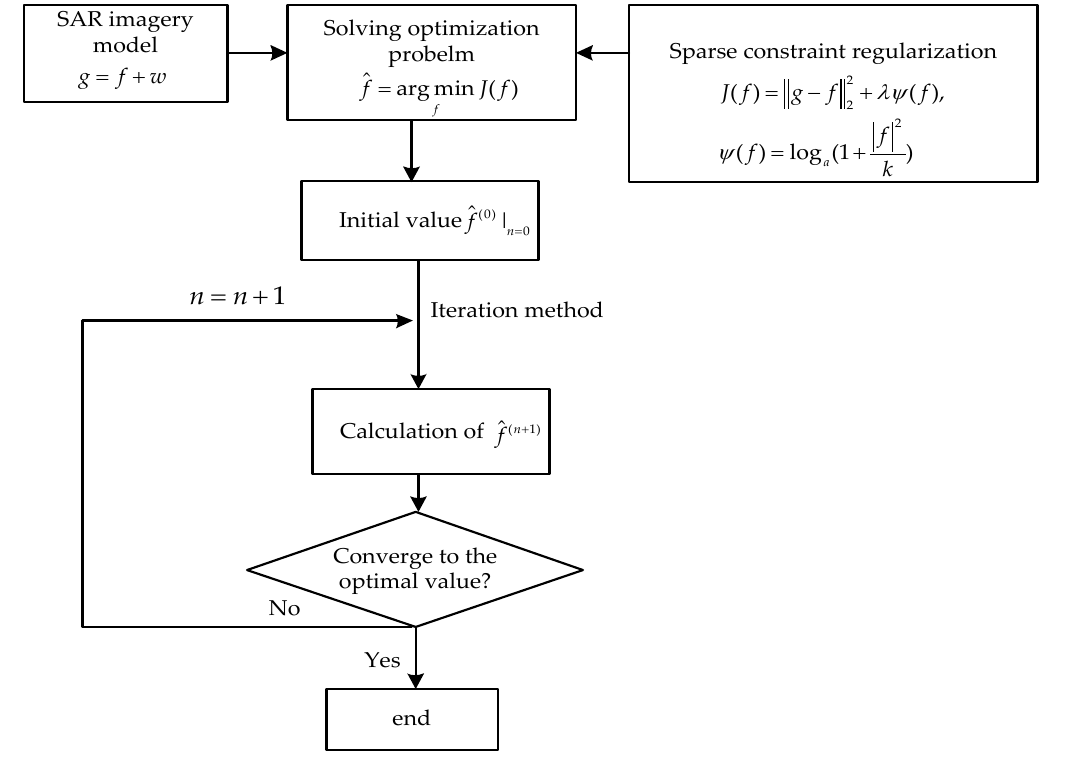
Figure 1. Flow chart of the presented method.